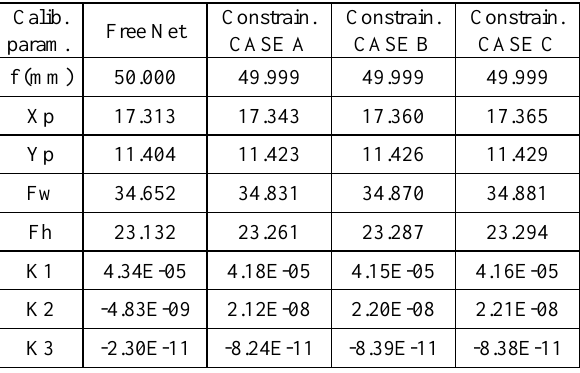
Table 10. Camera calibration parameters calculated by Photoscan in Photomodeler format (mm